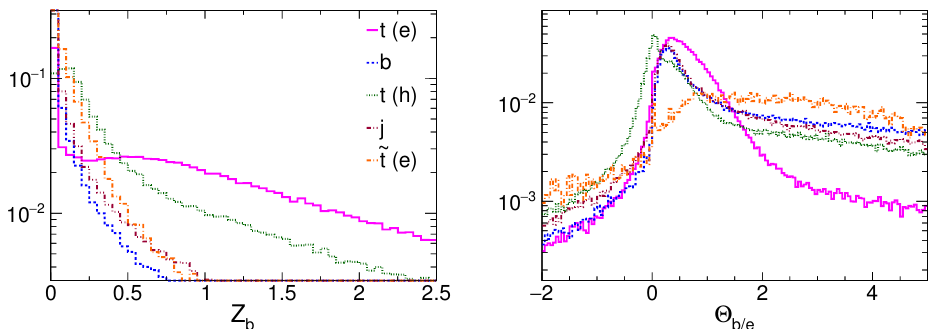
Figure 3 . Distribution of Z b (left), and (cid:2)